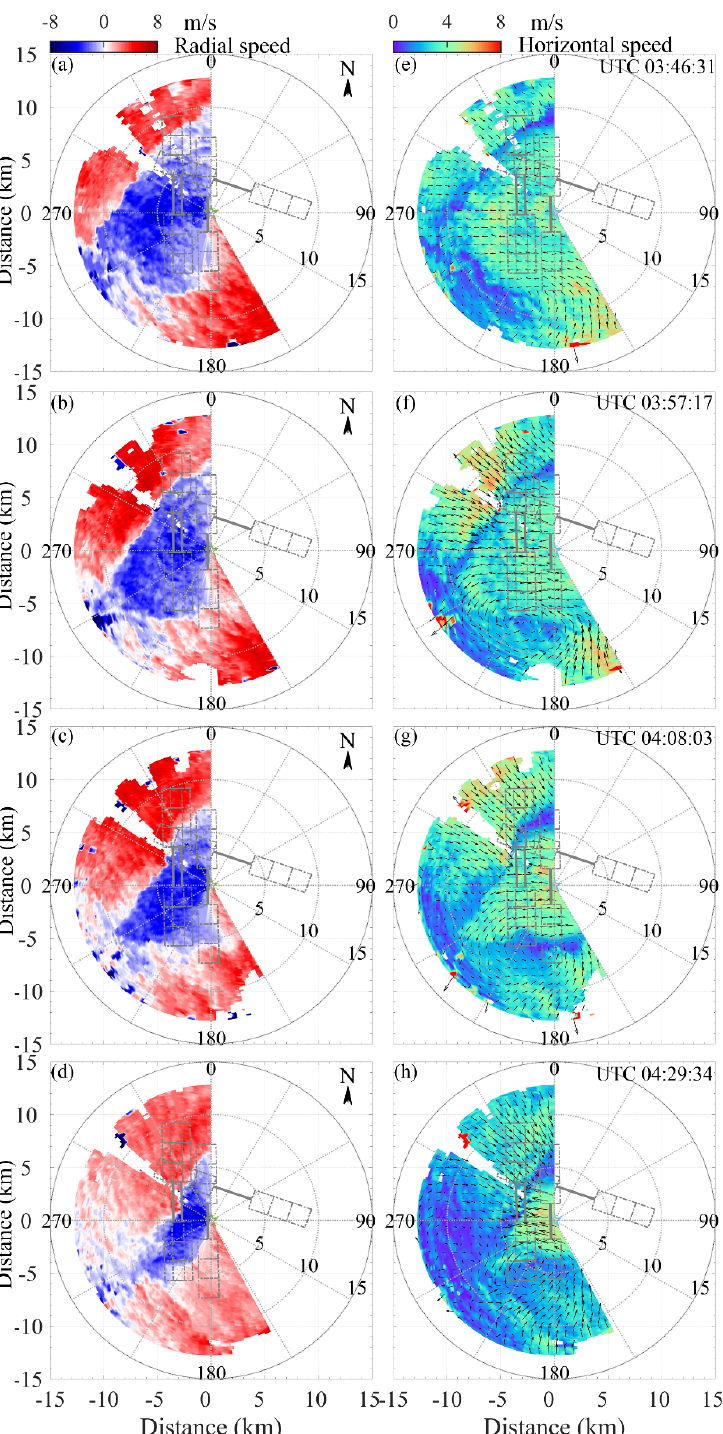
Figure 8. The windshear event detected by the CDWL on July 1. (UTC). ( a – d ) Radial speed, ( e – h ) Horizontal speed. ( a , e ) 3:46:31–3:47:12, ( b , f ) 3:57:17–3:57:58, ( c , g ) 4:08:03–4:08:45, ( d , h ) 4:29:34–4:30:17.